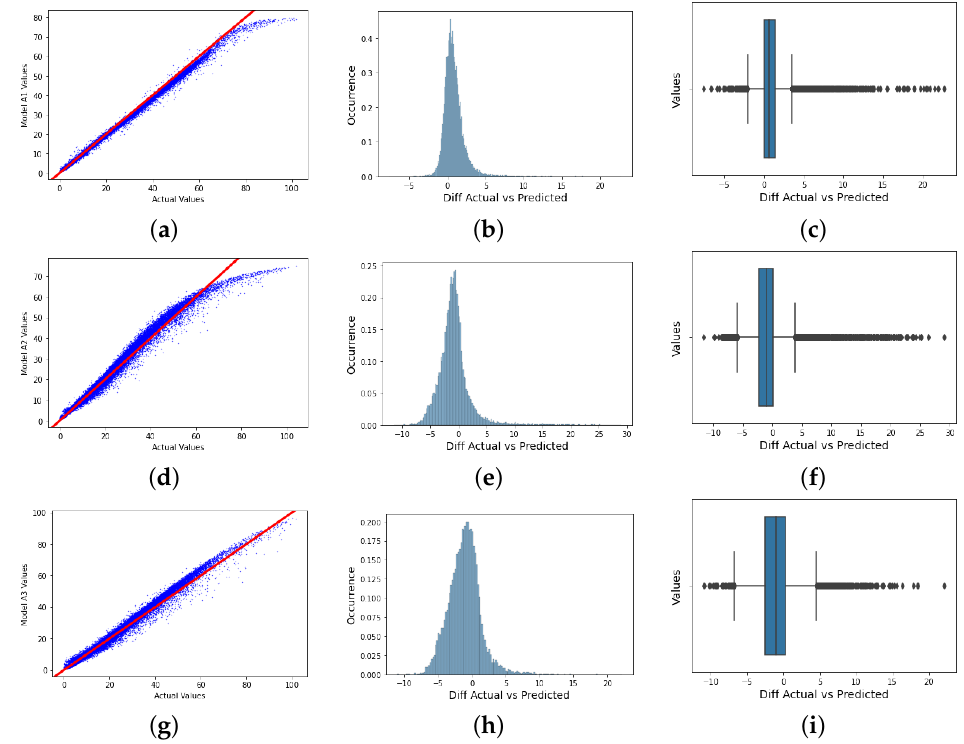
Figure 6. Option values visualization for Models A1, A2, A3; ( a ) Model A1: Regression plot; ( b ) Model A1: Histogram plot; ( c ) Model A1: Box plot; ( d ) Model A2: Regression plot; ( e ) Model A2: Histogram plot; ( f ) Model A2: Box plot; ( g ) Model A3: Regression plot; ( h ) Model A3: Histogram plot; ( i ) Model A3: Box